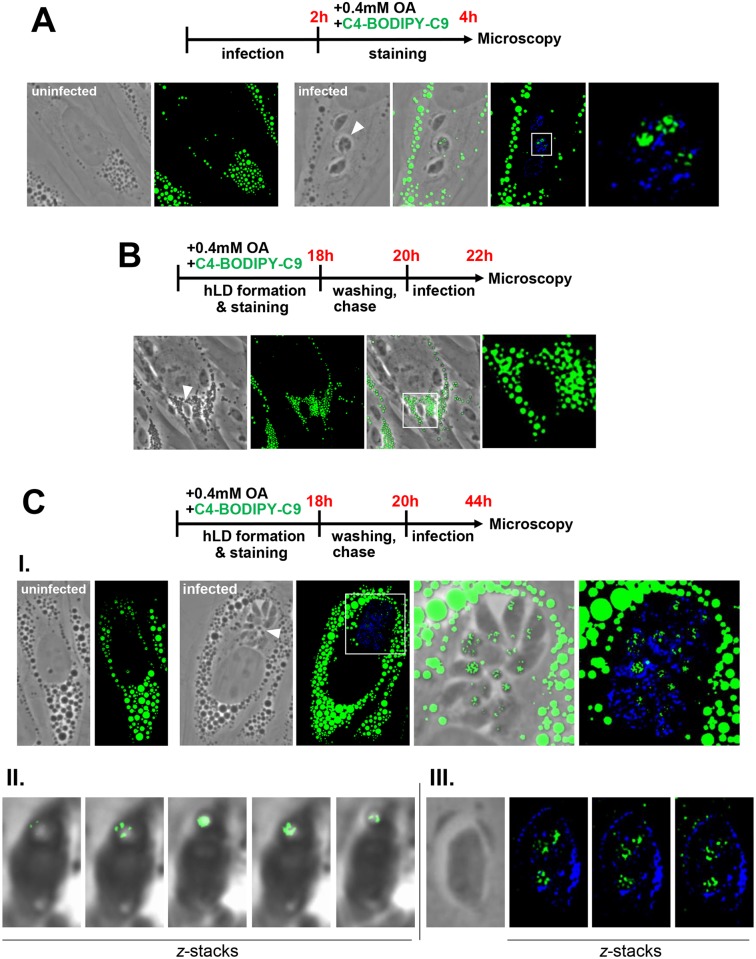
Detection in Toxoplasma of the fatty acid C4-BODIPY-C9 present from host LD.A-C. Fluorescence microscopy of uninfected or infected HFF in the presence of 0.4 mM OA and the free fatty acid C4-BODIPY-C9 (10 μM). Schemas outlining the experimental protocols are shown at the top of each panel. In A, C4-BODIPY-C9 (green) was co-administrated with OA for 2 h before fixation and immunolabeling of the PV with anti-GRA7 antibodies (blue), resulting in C4-BODIPY-C9 straining on the parasite. In B and C, C4-BODIPY-C9 (green) was co-administrated with OA for 18 h prior to infection, allowing the storage of C4-BODIPY-C9 in host LD (hLD). After washing and C4-BODIPY-C9 chase, cells were infected for 2 h (B) or 24 h (C). C4-BODIPY-C9 association with the parasite was apparent at 24 h (C, panel I). Panel II in C shows z-stacks of egressing parasite containing C4-BODIPY-C9 on LD as observed by live fluorescence microscopy. Panel III in C shows z-stacks of intracellular parasite stained for GRA7 (blue) and containing C4-BODIPY-C9 on cytoplasmic membranes by IFA.